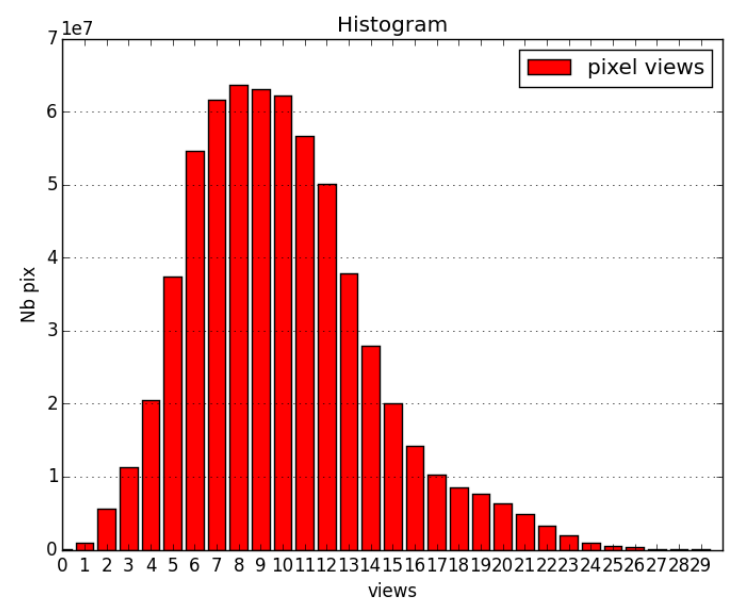
Figure 9. Histogram of the number of times that every pixel sees the ground taking into account satellite revisit and cloud cover.